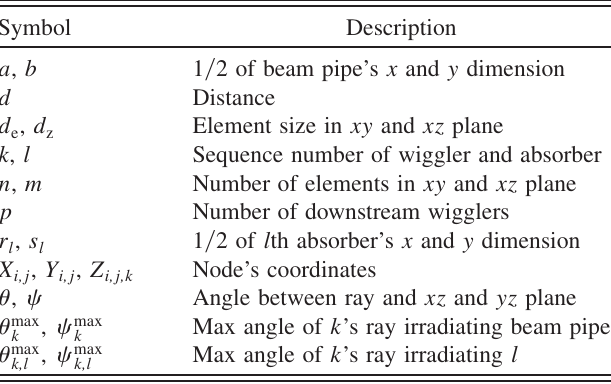
TABLE XII. Nomenclature for synchrotron radiation calcula- tion.